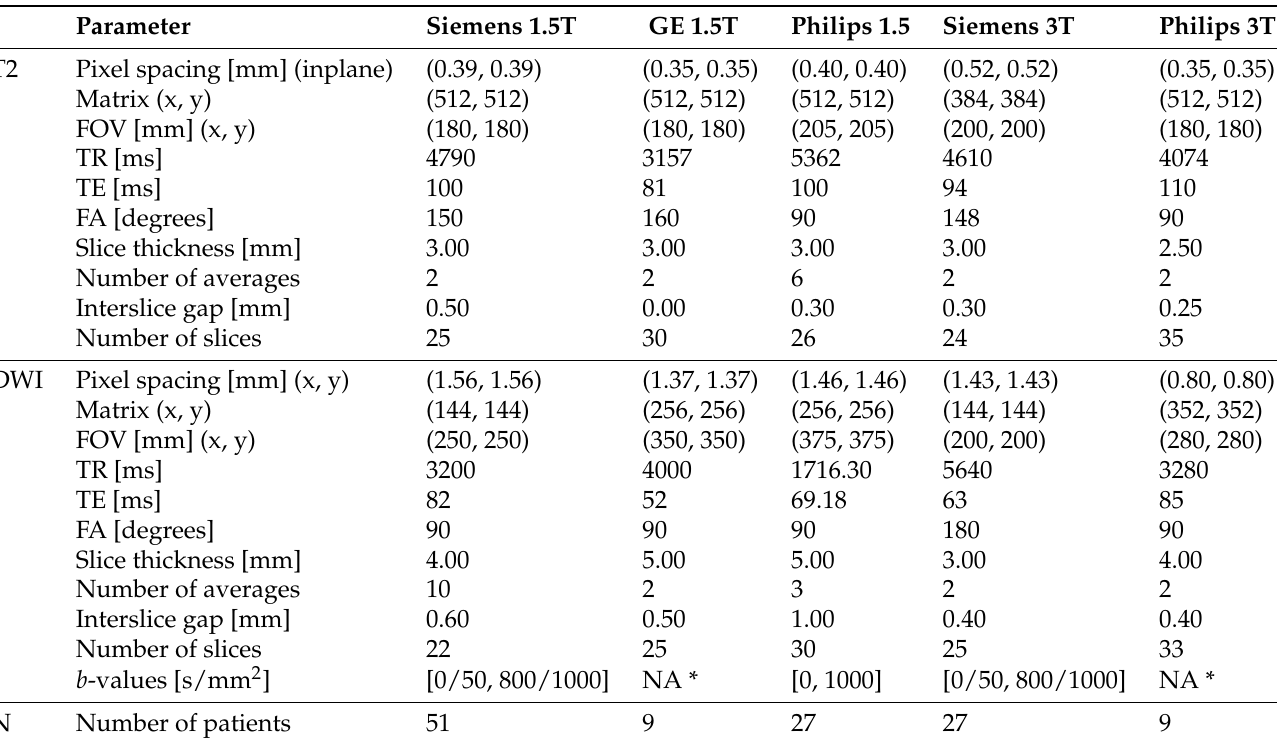
Table 1. Summary of MRI protocols used in the study cohort ( n = 131). The MRI data were acquired using different protocols, field strength and vendors. T2-weighted and diffusion-weighted imaging (DWI) acquisition parameters are reported as median values. FA = flip angle; FOV = field of view; mm = millimeters; ms = milliseconds; NA = not available; n = Number of patients in each category in terms of field-strength and vendor; s = seconds; T2 = T2-weighted; T = Tesla; TE = echo time; TR = repetition time. * Available b-values are reported, but not all b-values were available after export of the image data from the